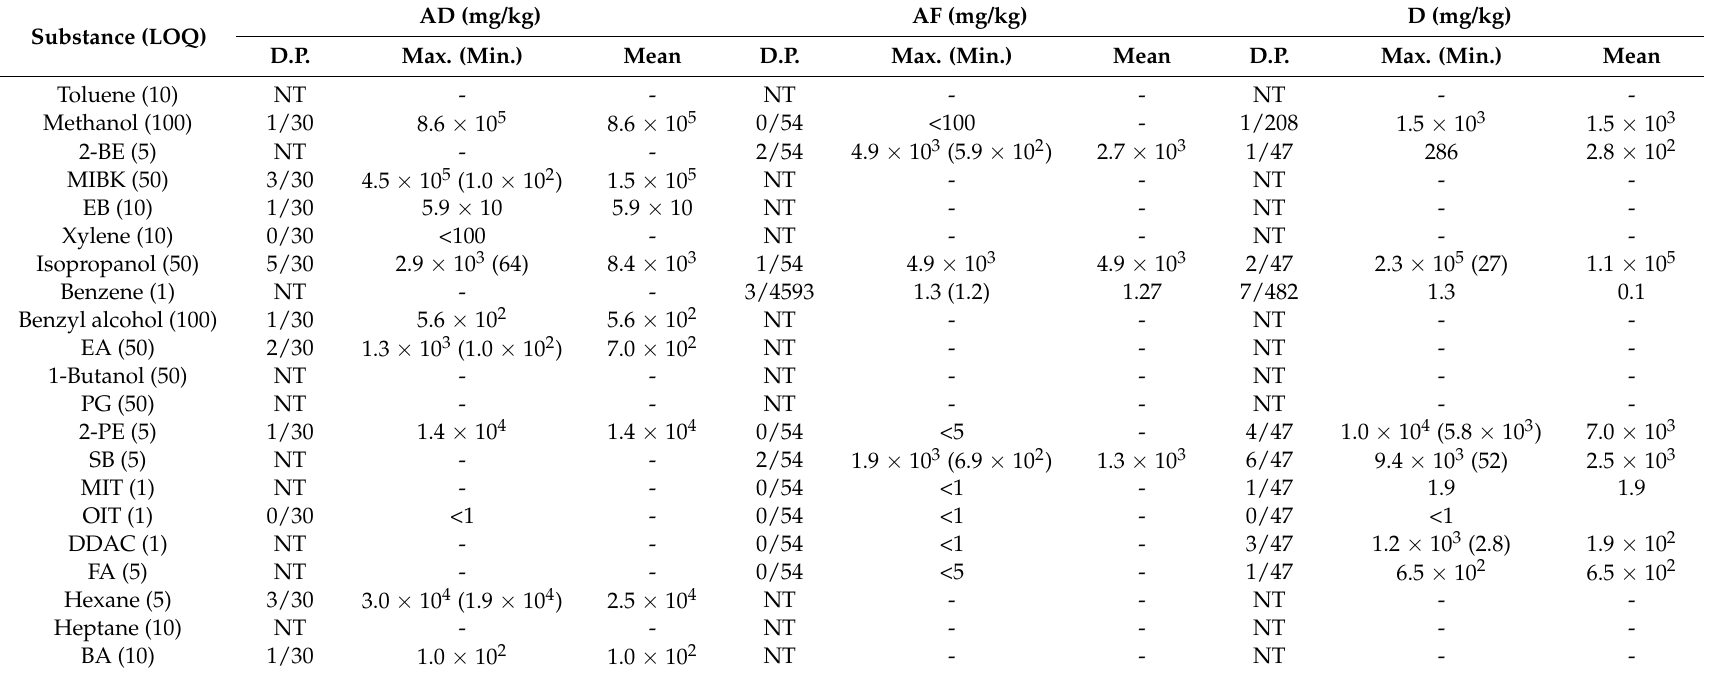
Table 5. Analyzed concentrations of studied substances in products AD, AF and